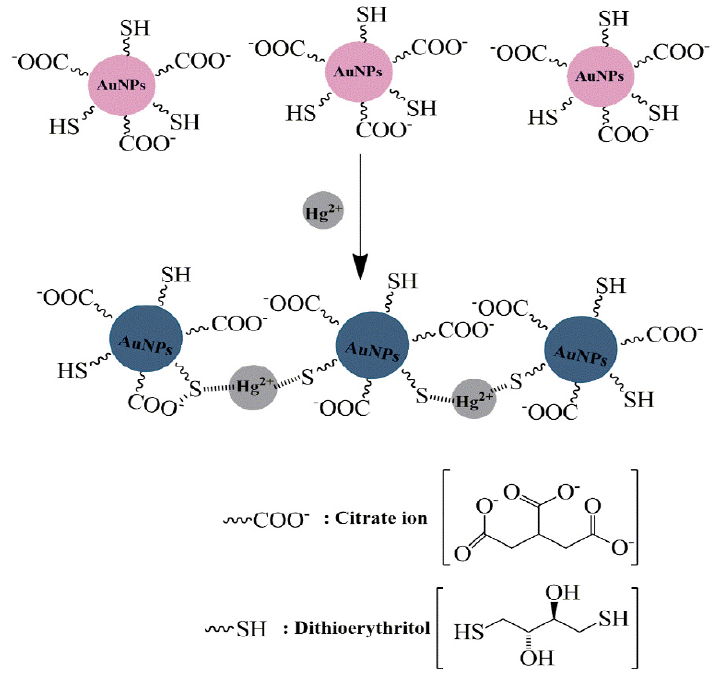
Fig. 4. Proposed mechanism of Mercury (II)